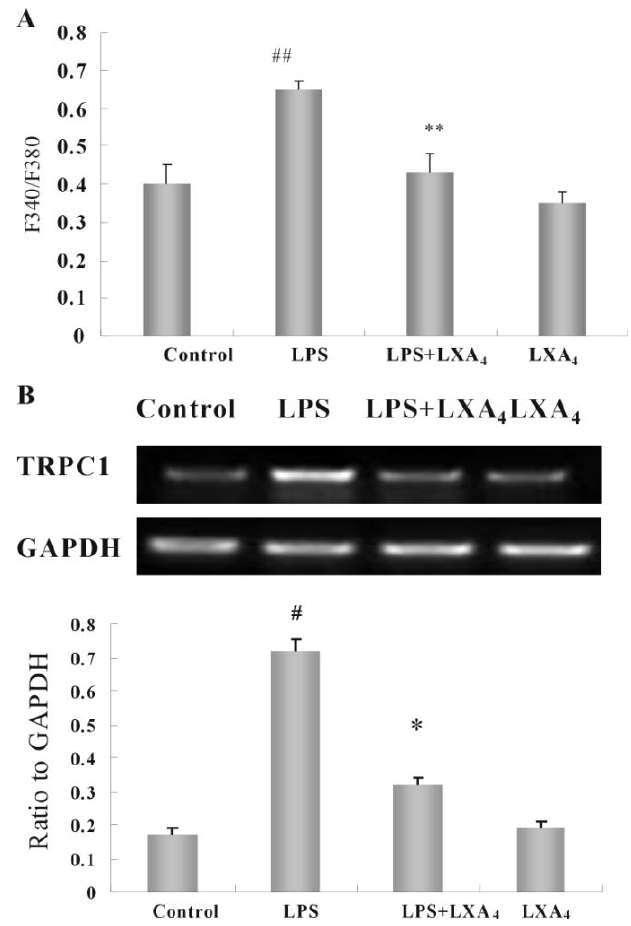
FIGURE 5. [Ca 2+ ]i and TRPC1 expression in HUVECs under different conditions. (A) [Ca 2+ ]i was measured with Fura-2 after cells were treated with LPS with or without LXA for 6 h. Data are presented as ratio F340 to F380. All 4 values are means ± SEM from at least three independent experiments. (B) Representative RT-PCR for TRPC1 is shown. Bar graphs indicate means ± SEM from at least three independent experiments; ## p < 0.01 compared to control cells; ** p < 0.01 compared to cells treated by LPS alone; * p < 0.05 compared to cells treated by LPS